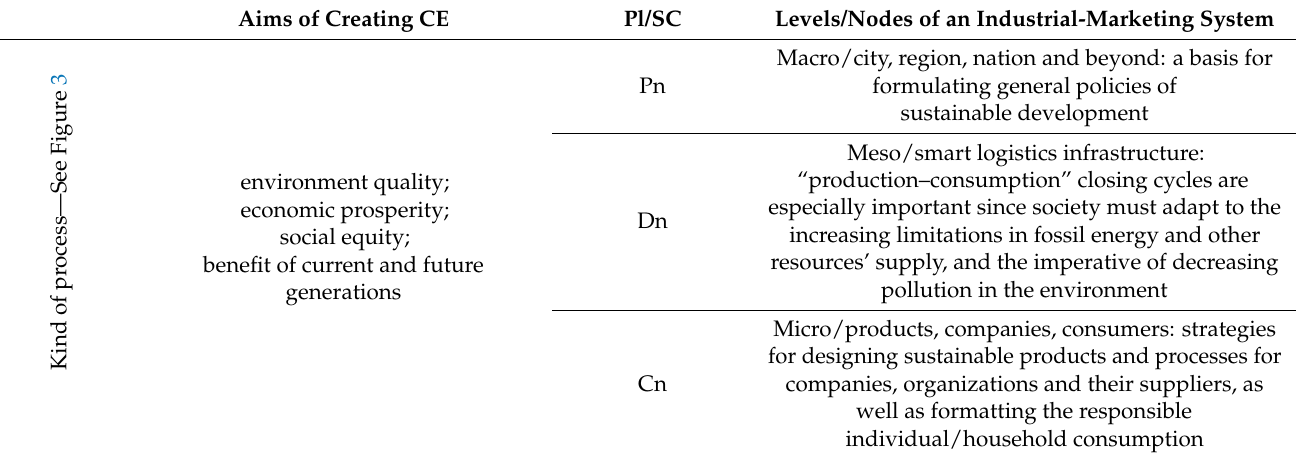
Table 2. The analysis of some definitions of the circular economy.